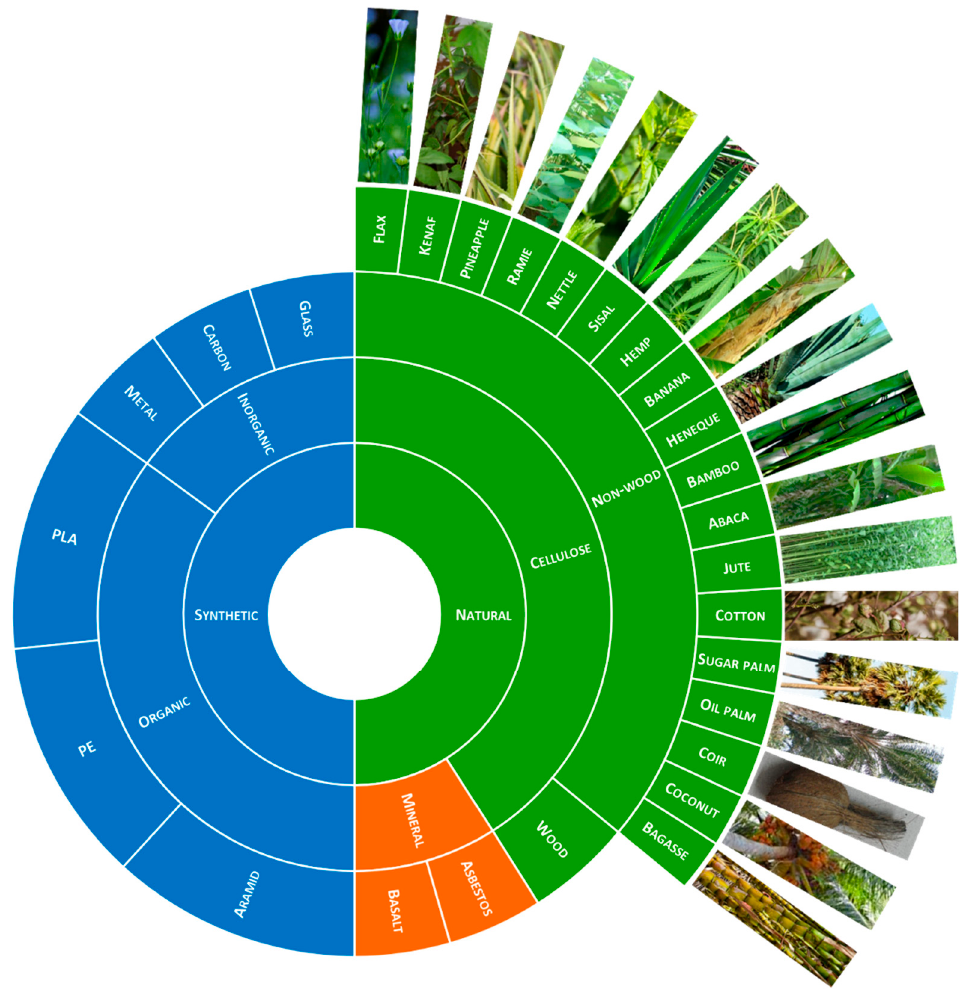
Figure 4. Summary of fibre classification.